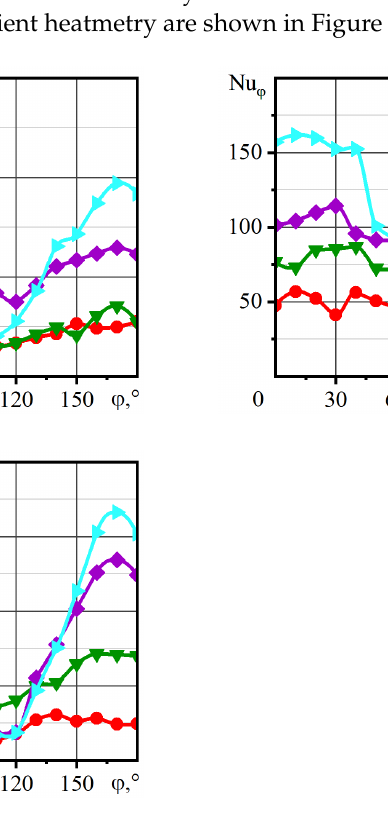
Figure 13. Distribution of the local Nusselt number over the third cylinder: ( a ) S = d , ( b ) S = 2 d and ( c ) S = 3 d (red curve—Re = 2.4 × 10 3 ; green curve—Re = 9.6 × 10 3 ; purple curve—Re = 20.2 × 10 3 ; turquoise curve—Re = 29.8 × 10 3